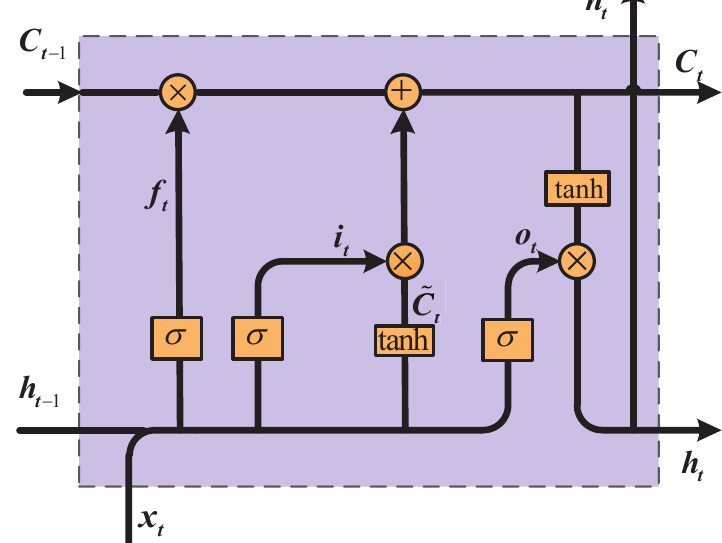
Figure 3. LSTM neural network